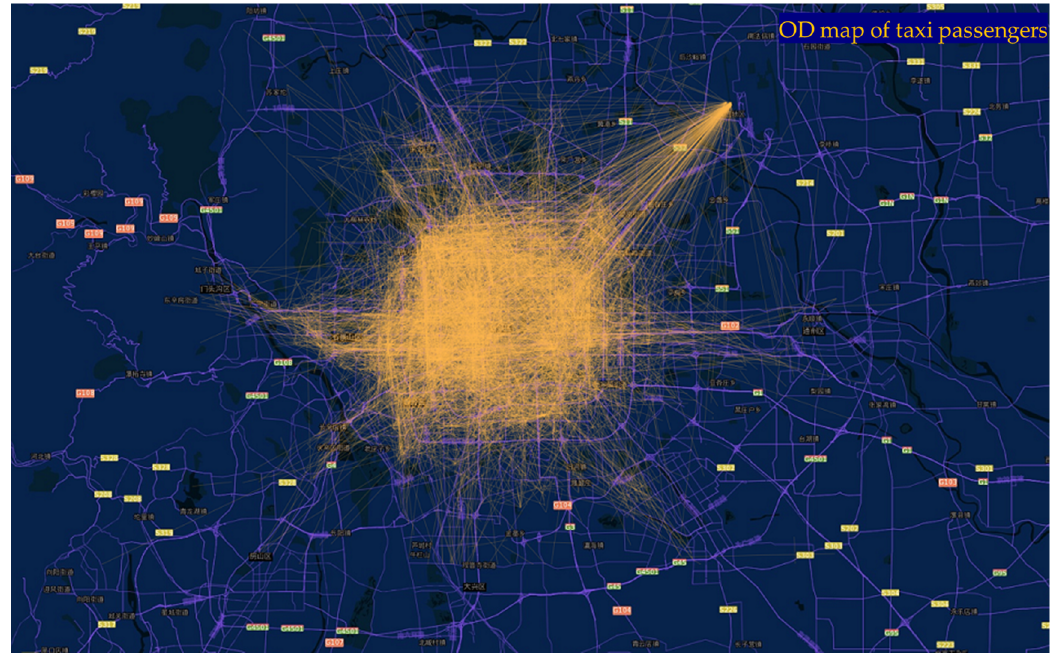
Figure 8. Unprocessed taxi data origin-destination (OD) flow map.